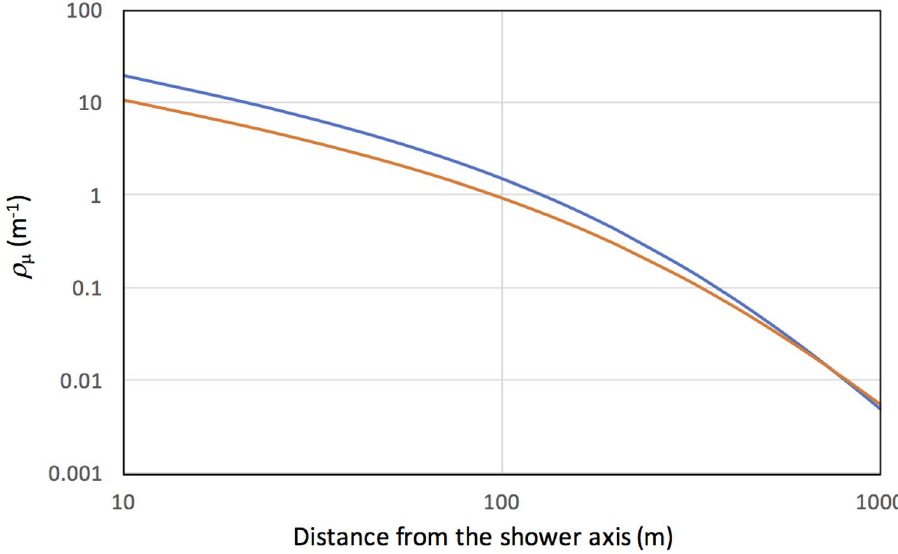
Figure 2. Greisen function curves fitted to the IceTop data at zenith angles of less than 6° (blue solid line) and those at zenith angles between 28° and 31° (orange solid line) 43 .